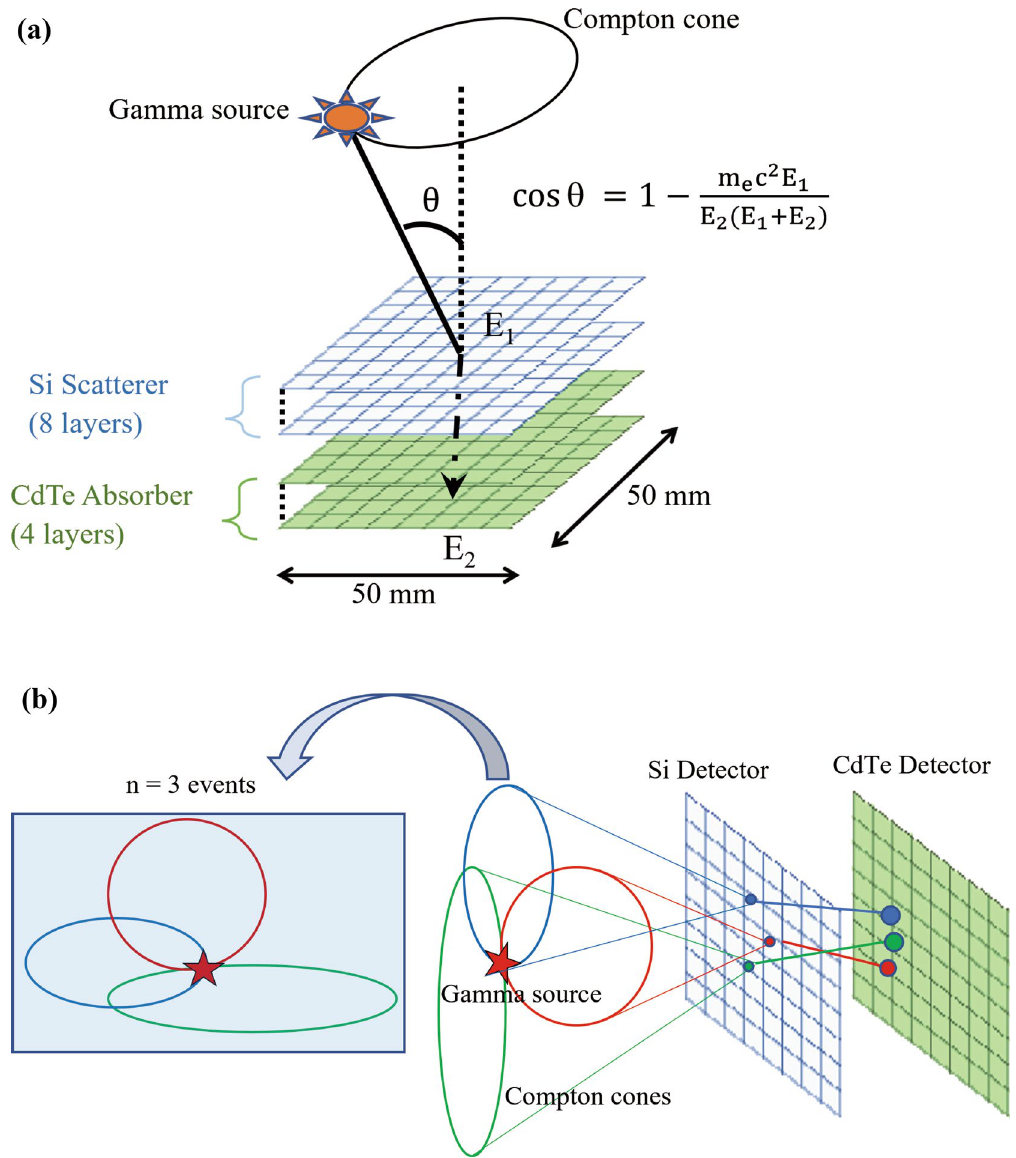
Figure 1. Schematic illustration of Compton camera. ( a ) Alignment of semiconductors within our Compton camera. ( b ) Gamma source detection with increased number of overlapping